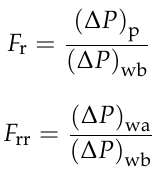
Figure 5. Viscosity loss and viscosity retention of 0.1% TVP or HPAM solution in the presence of 4500 mg/L TDS containing 65 mg/L Ca 2+ and Mg 2+ versus aging time. Shear rate, 7.34 s − 1 .